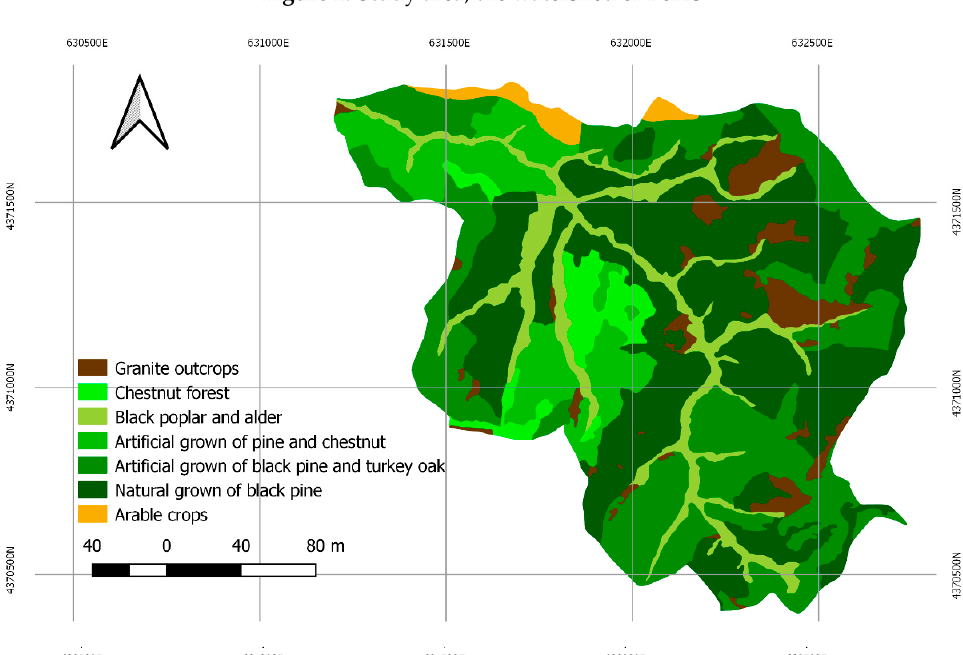
Figure 3. Land cover map of the Bonis catchment.